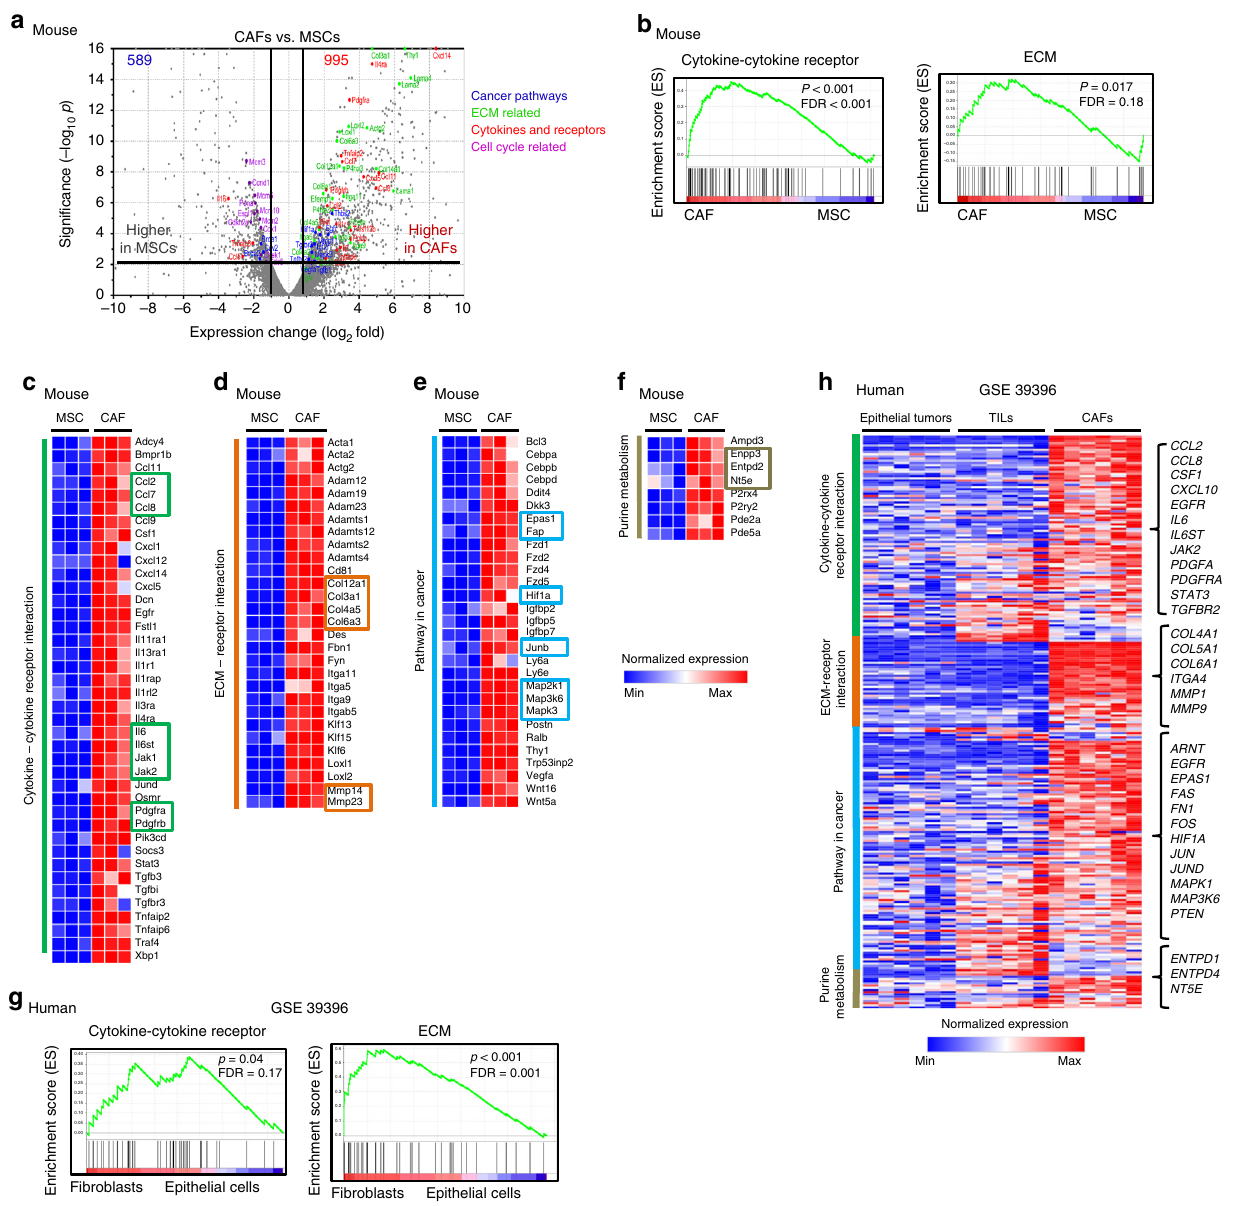
Fig. 3 EG7 and human CRC CAFs share similar transcriptome pro fi les. a Comparative expression pro fi le of CAFs and MSCs was analyzed via RNA sequencing. The volcano plot illustrates genes that were signi fi cantly upregulated (995, red) and downregulated (589, blue) adjusted for fold change > 2 and p < 0.01 with representative genes associated with speci fi c pathways. b Gene sets speci fi cally enriched among the differentially expressed genes in CAFs were analyzed via gene set enrichment analysis (GSEA). c – f The 417 genes categorized in “ response to stimulus ” were further analyzed for enrichment in KEGG pathways. Representative heatmaps of RNA sequencing data with genes signi fi cantly up-regulated in CAFs according to speci fi c pathways were shown from three biological repeats, each extracted from at least fi ve pooled tumor-bearing mice. g Gene set enrichment analysis (GSEA) of differentially expressed genes in human CRC-CAFs compared with paired tumor cells (GSE39396) identi fi ed highly enriched genes in pathways related to cytokine – cytokine interaction and ECM receptor interaction. h The gene expression pro fi le heatmap shows differentially expressed genes in paired human CRC tumors, TILs, and CAFs (GSE39396) associated with pathways highly enriched in CRC-CAFs. The list on the right showed a selective representative shortlist of signi fi cantly up-regulated genes in CAFs, most of which are similar to those identi fi ed in EG7-CAFs. Source data are provided in the Source Data fi